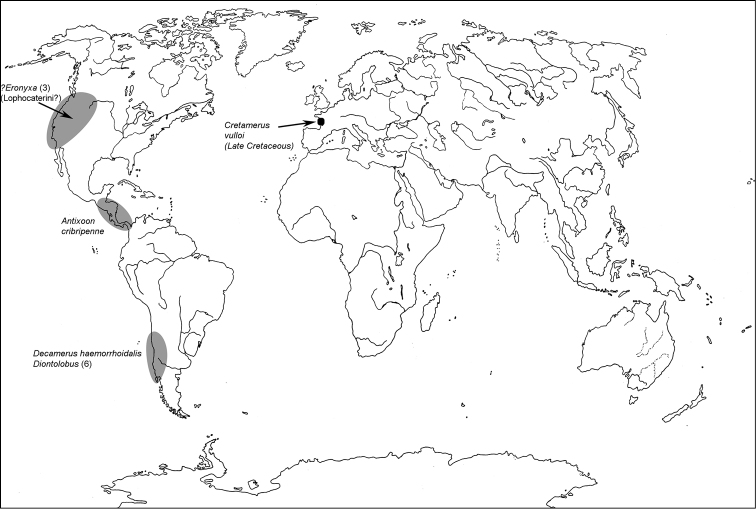
A distribution of the tribe Decamerini including the newly described genus † Cretamerus. A position of Eronyxa is indicated.